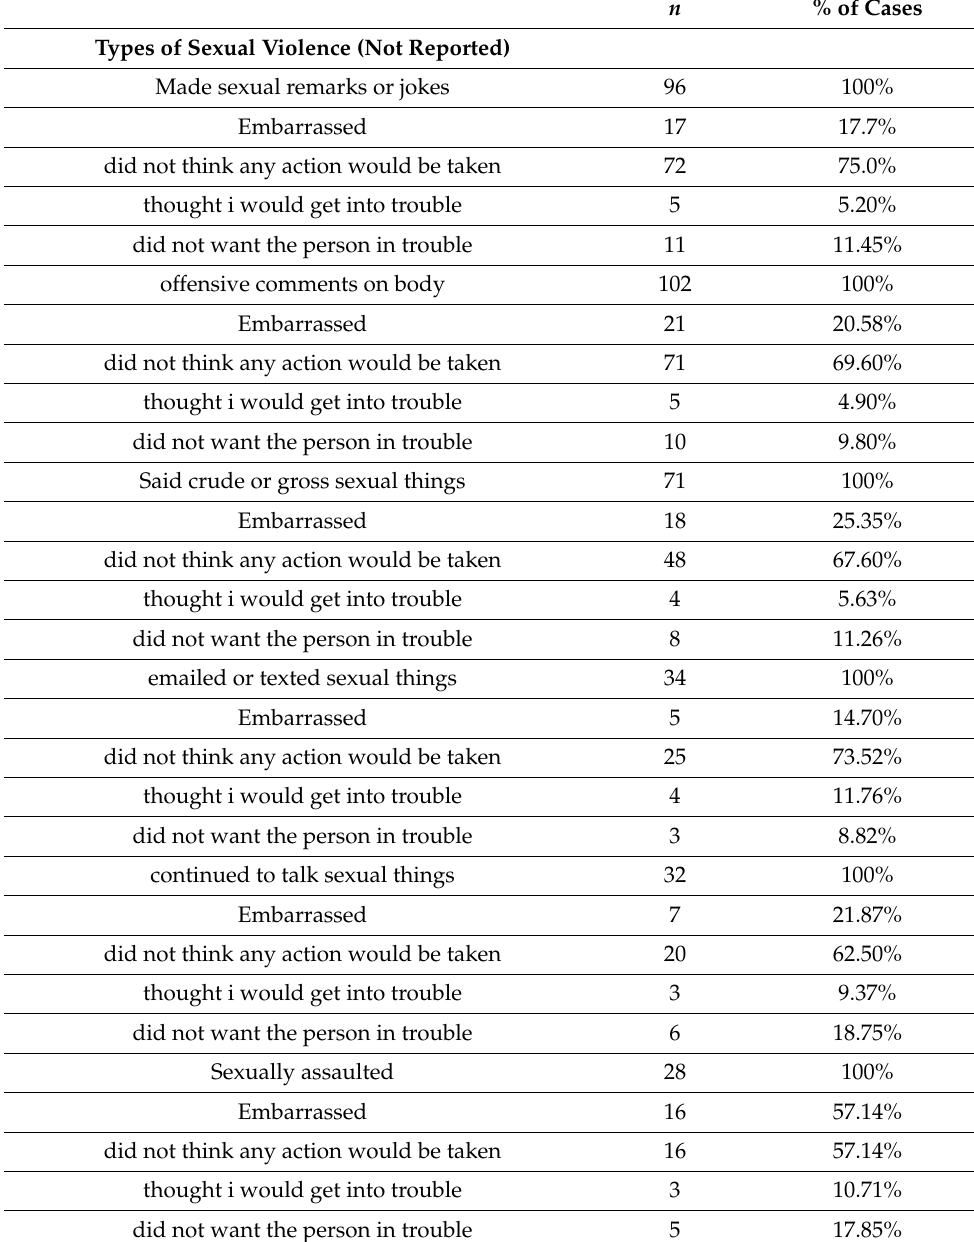
Table 7. Types of sexual violence that was not reported and reasons for not reporting.